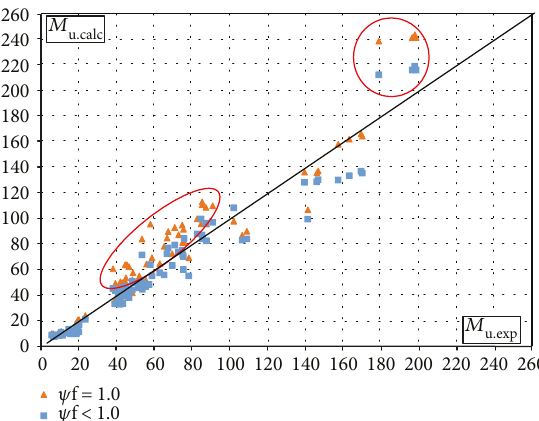
Figure 13: Comparison of experimental and numerical results of load-carrying capacity.